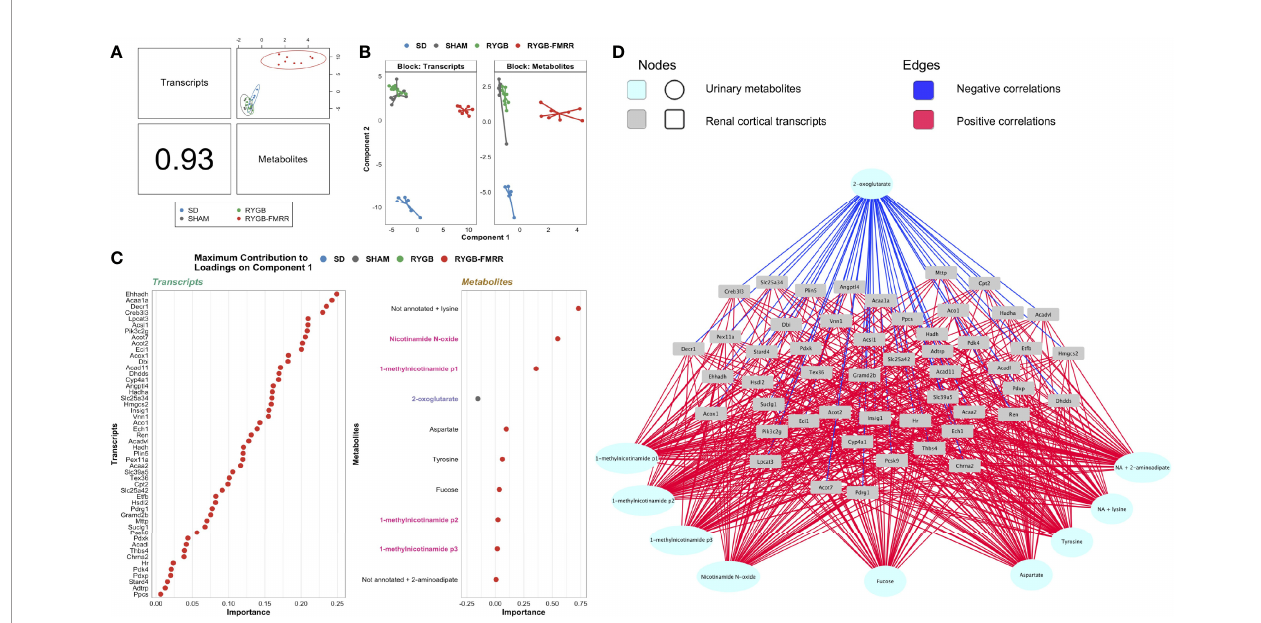
FIGURE 7 | Multi-omic integration of the renal cortical transcriptome and urinary metabolome identi fi es a distinctive gene-metabolite signature following RYGB- FMRR. (A) A supervised, sparse partial least squares-discriminant analysis model was fi t to regularized log-transformed gene expression counts and annotated, PQN-normalized urinary 1 H-NMR peaks from 4 weeks after intervention using the DIABLO framework in the R package mixOmics (72, 73). An overview of the correlation structure between transcripts and metabolites selected by component 1 of the model, which separated RYGB-FMRR rats from the three other experimental groups, is presented. The left lower panel indicates the Pearson ’ s correlation coef fi cient between transcripts and metabolites, and the top right panel presents a scatterplot of the correlation structure between the two omics datasets for each sample. Each dot represents an individual rat, with colours indicating experimental group assignment. (B) Dimensionality reduction plot of the subspace spanned by the latent variables of the sparse DIABLO model indicating clustering of experimental groups along component 1 (x-axis) and component 2 (y-axis). The plot is facetted by omics modality such that one panel each is presented for transcripts and metabolites. Based on renal cortical transcript expression and urinary metabolite abundance, RYGB-FMRR rats separated from the other experimental groups along component 1. Each dot represents an individual rat, with colours indicating experimental group assignment. (C) Dotplots illustrating the contribution of each selected feature (n=50 transcripts, n=10 metabolites) to component 1 of the sparse DIABLO model. Dots are ordered from top to bottom and from right to left according to the loading weight (importance) of the feature. The loading weight can be positive or negative and ranking is by absolute values. The colour of dots corresponds to the group in which the feature is most abundant. Some metabolites in urinary 1 H-NMR peaks remained unannotated despite 2-D NMR analysis. When multiple metabolites are present in a given peak, metabolites are listed in order of relative abundance in the peak, with the most abundant metabolite listed fi rst. PPAR a biomarker metabolites involved in nicotinamide metabolism are highlighted in pink; TCA cycle intermediates are highlighted in blue. (D) Network visualization of the correlation structure between the 50 transcripts and 10 metabolites selected by component 1 of the sparse DIABLO model. Correlations between features with an absolute value greater than 0.5 are presented. Metabolites are presented at the periphery of the network as cyan spherical nodes. Transcripts are presented towards the middle of the network as grey rectangular nodes. Edges are coloured by the directionality of correlation between nodes: blue for negative correlations, red for positive correlations. 1 H-NMR, proton nuclear magnetic resonance spectroscopy; DIABLO, data integration analysis for biomarker discovery using latent variable approaches for omics studies; NA, not annotated; p1, peak 1; p2, peak 2; p3, peak 3; PLS-DA, partial least squares-discriminant analysis; PQN, probabilistic quotient normalization; RYGB, Roux-en-Y gastric bypass; RYGB- FMRR, Roux-en-Y gastric bypass plus feno fi brate, metformin, ramipril, and rosuvastatin; SD, Sprague Dawley; SHAM, sham surgery (laparotomy); TCA, tricarboxylic